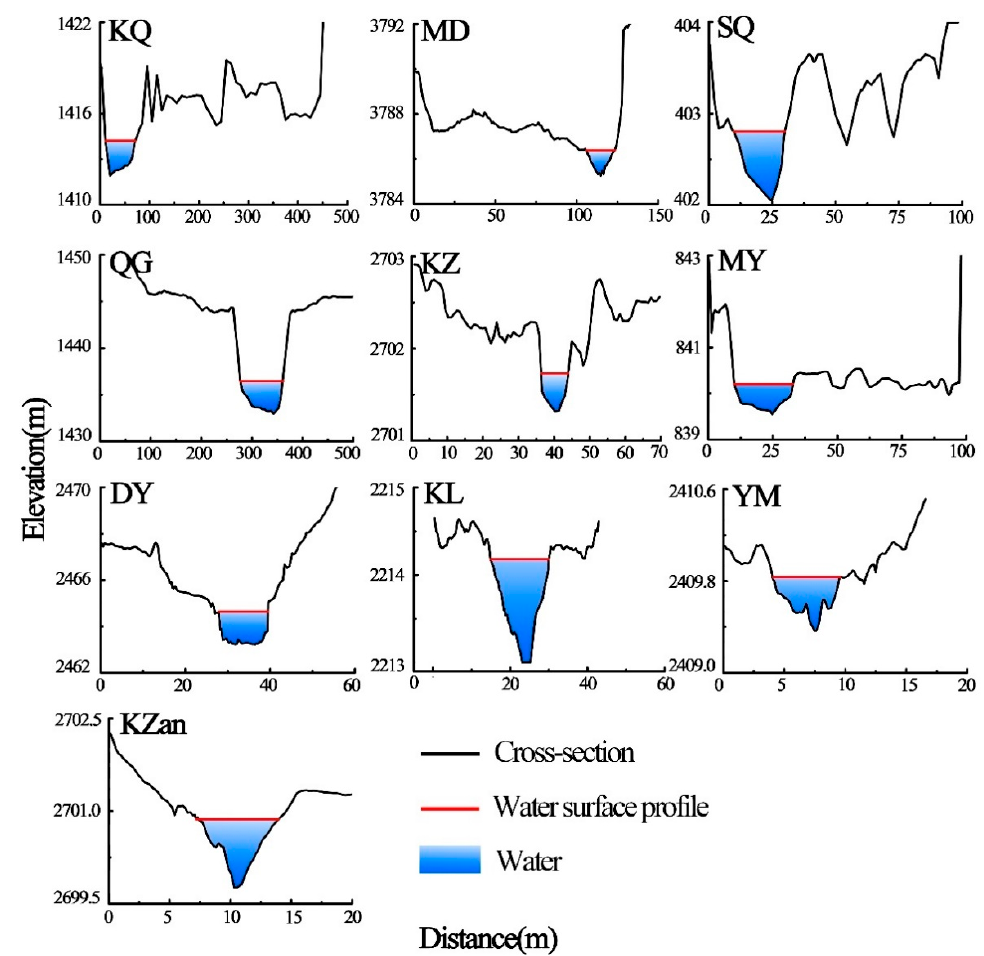
Figure 6. Cross-section and water surface profiles for the ten river sections.